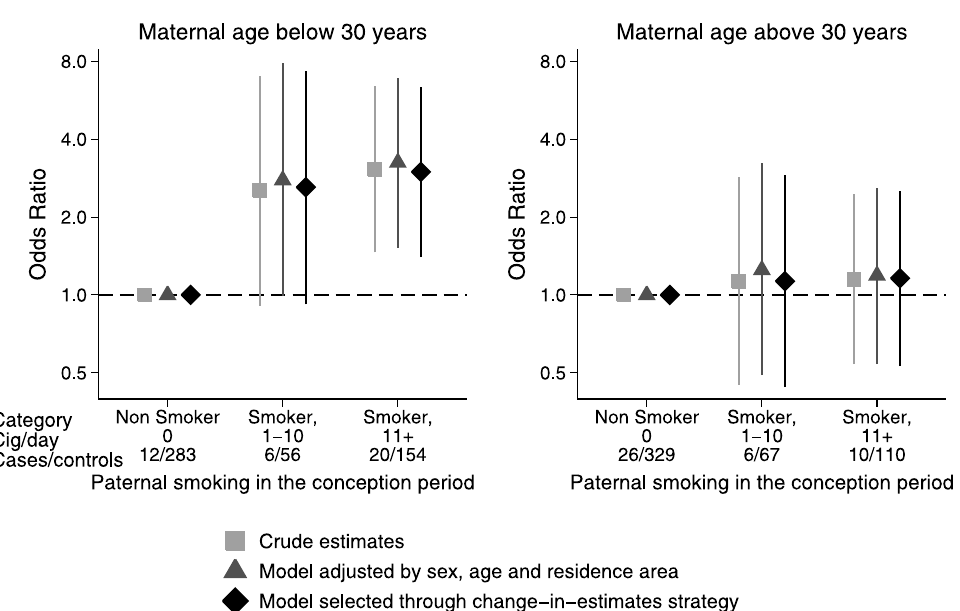
Figure 1. Association Between Paternal Smoking Status During the Period of Conception and Risk of Childhood Acute Non- Lymphocytic Leukemia, According to Maternal Age at Delivery. The SETIL Study, Italy, 1998–2003.